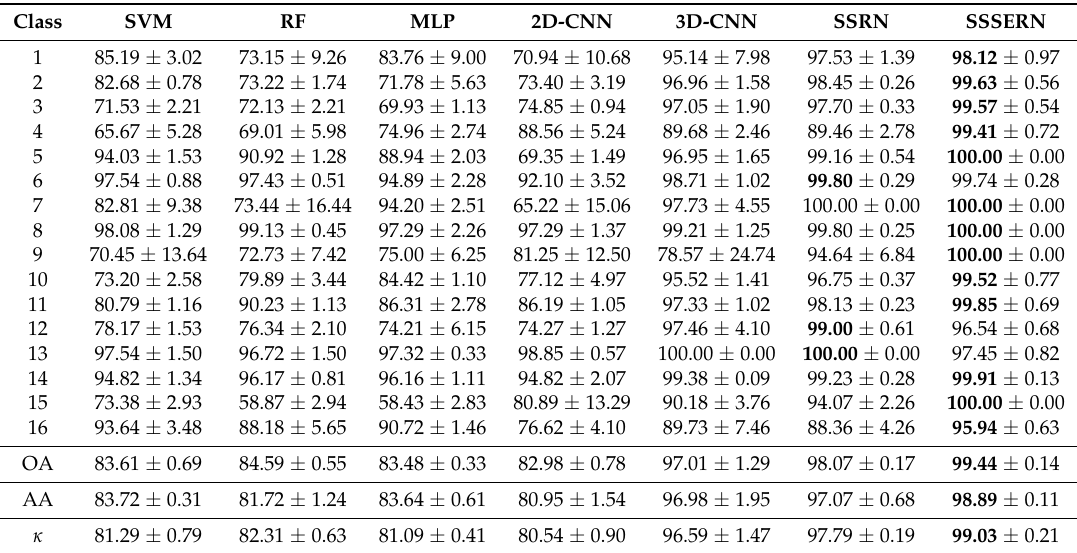
Table 4. Overall, average, and individual class accuracies and κ statistics in the form of mean ± standard deviation for the Indian Pines data set. The best results are highlighted in bold typeface.